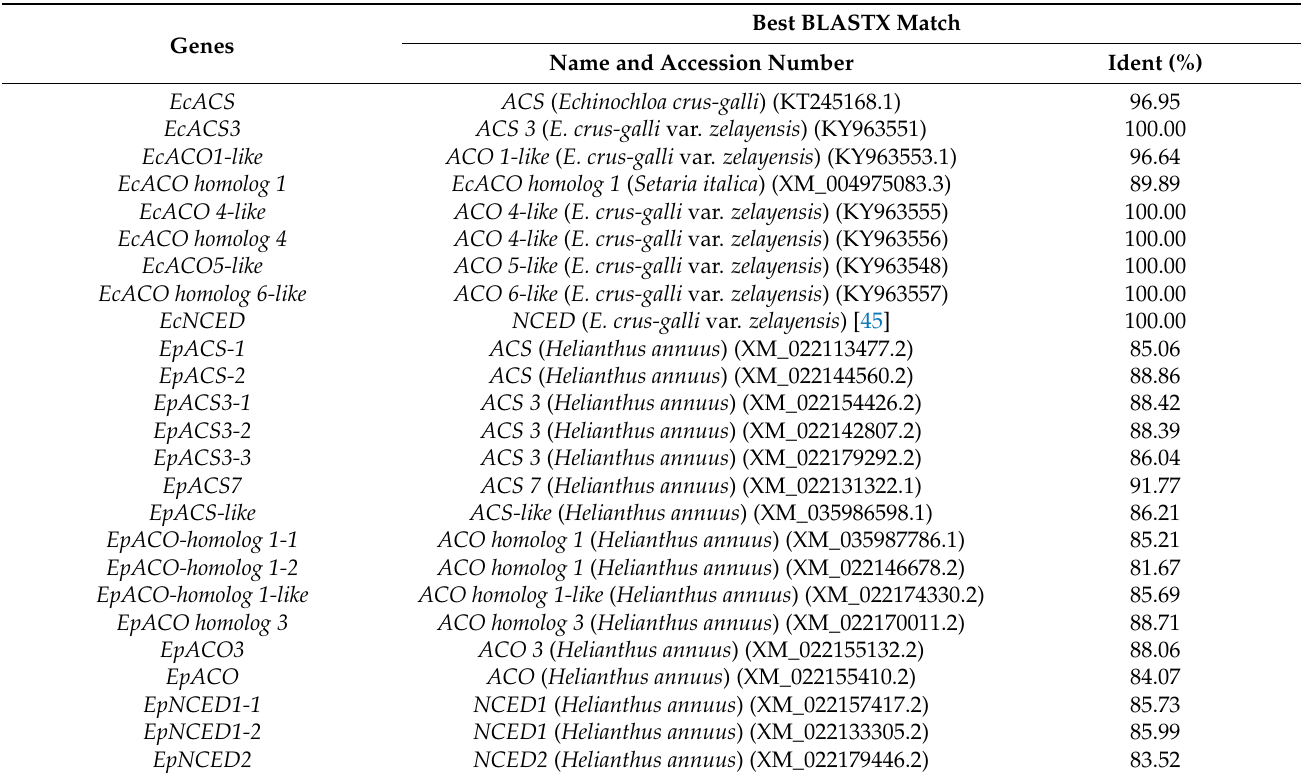
Table 5. Candidate DEGs related to ethylene and ABA biosynthesis identified from transcriptome data of barnyardgrass and